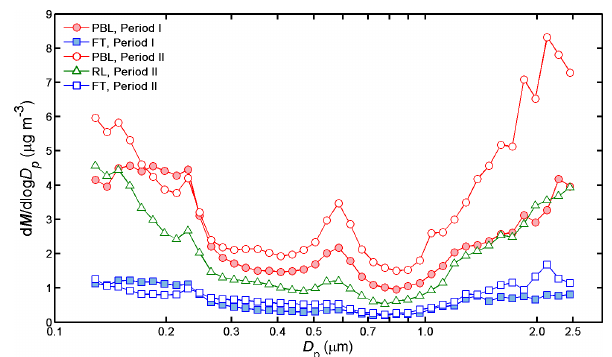
Figure 4. Average particle mass size distributions (d M/ dlog D p ) for different layers during the two periods as indicated by different